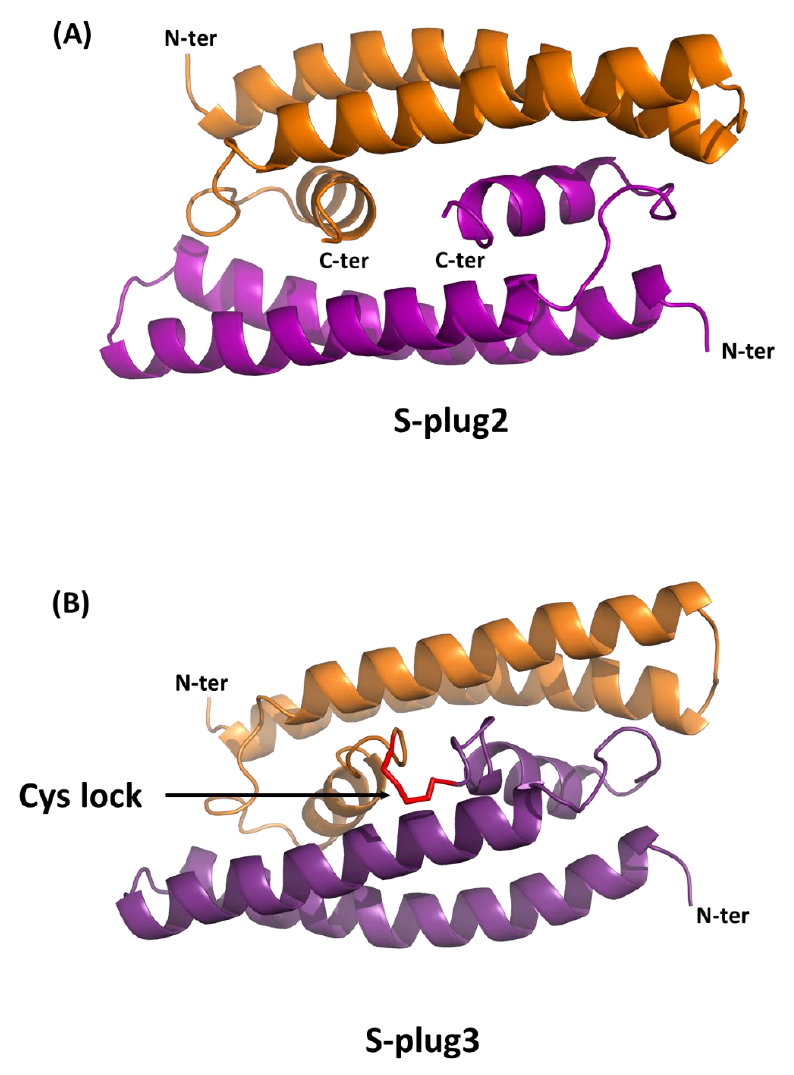
Figure 4. Cartoon representations of S-plug2 ( A ) and S-plug3 ( B ) models obtained using Rosetta docking procedures [19]. The C-terminal arm (PGGC) inserted in S-plug3 to induce a disulphide bond ( B ) is drawn in red ribbon representation.